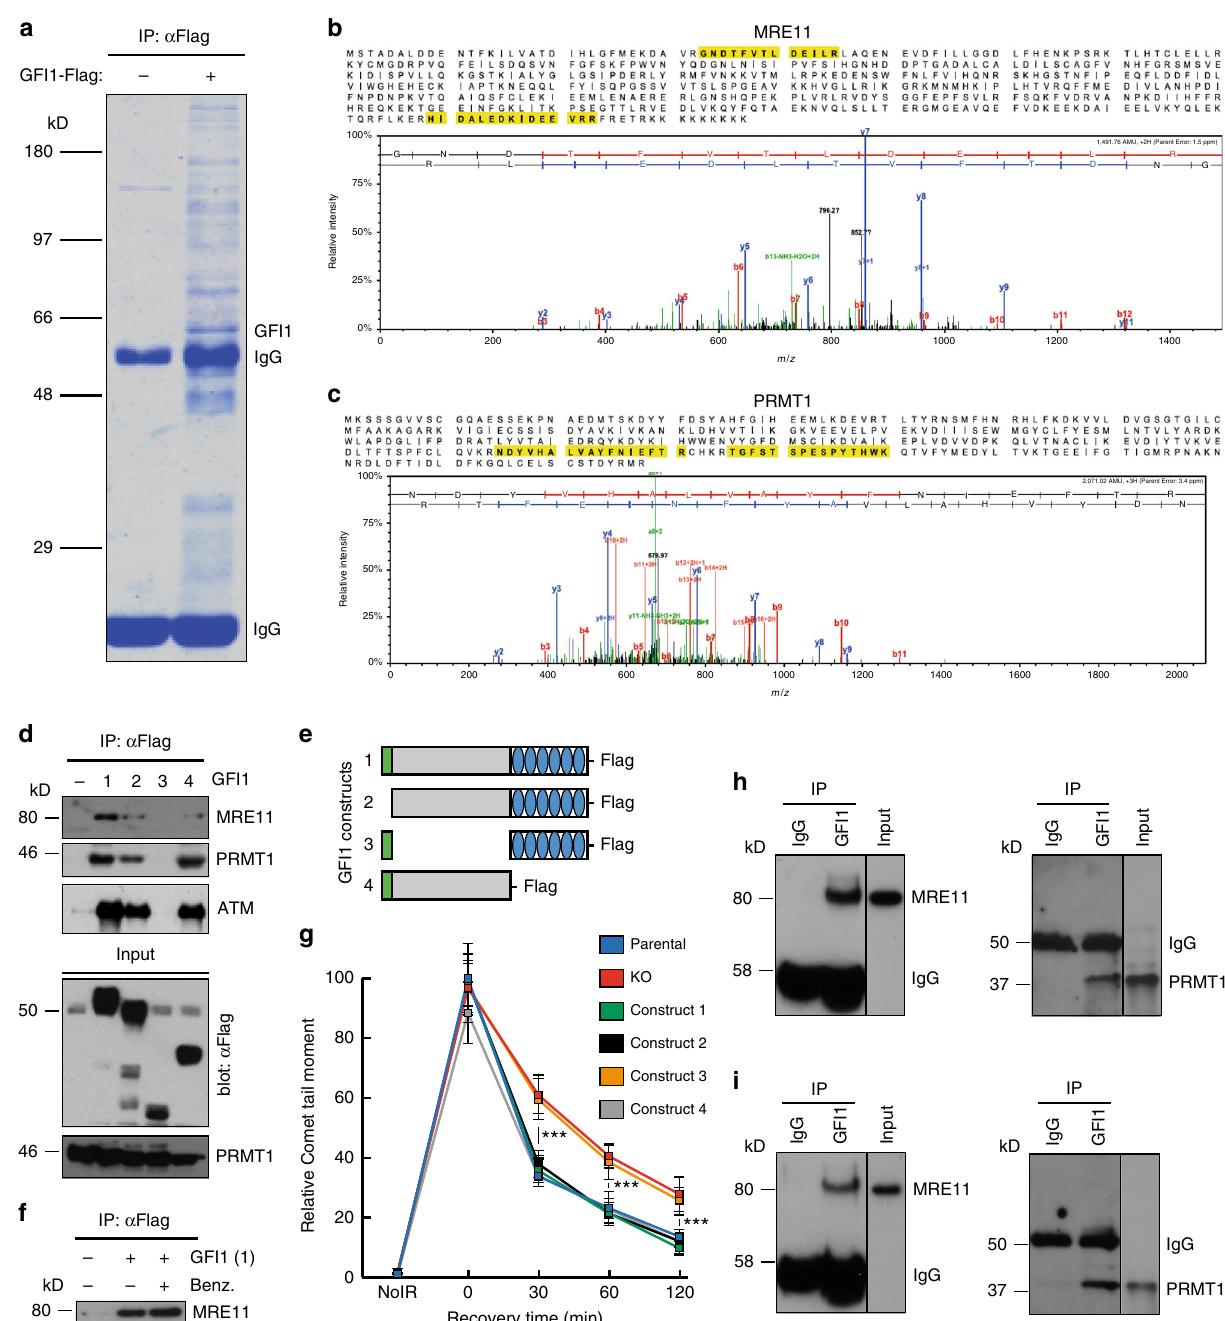
Fig. 3 GFI1 interacts with proteins involved in the DDR. a GFI1-Flag fusion protein was immunoprecipitated from 293T cells. Co-precipitated proteins were run on polyacrylamide gel and stained with Coomassie blue. b Peptide sequence of MRE11 with peptides identi fi ed through mass spectrometry highlighted and corresponding spectra below. c Peptide sequence of PRMT1 with peptides identi fi ed through mass spectrometry highlighted and corresponding spectra below. d Variants of the GFI1-Flag fusion protein were immunoprecipitated from 293T cells. Extracts were separated by SDS – PAGE and blotted for the indicated proteins. e Diagram of the different GFI1 fusion proteins used in d and g . f GFI1-Flag fusion protein was immunoprecipitated in 293T cells in the presence or absence of benzonase. Extracts were separated by SDS – PAGE and blotted for MRE11. g GFI1 KO Jurkat cells were electroporated with plasmids expressing GFI1 variant constructs as shown in e . GFI1 KO and parental control Jurkat cells were used as controls. After 24 h, cells were exposed to 5 Gy IR and allowed to recover for the indicated time. Cells were lysed and analyzed by alkaline Comet assay. Comet tail moment averages are shown. One of three replicate experiments is shown. Error bars represent s.d. h Endogenous GFI1 protein was immunoprecipitated in SupT1 cells. Co-precipitated proteins were separated by SDS – PAGE and blotted for MRE11 and PRMT1. i Endogenous GFI1 protein was immunoprecipitated in Jurkat cells. Co-precipitated proteins were separated by SDS – PAGE and blotted for MRE11 and